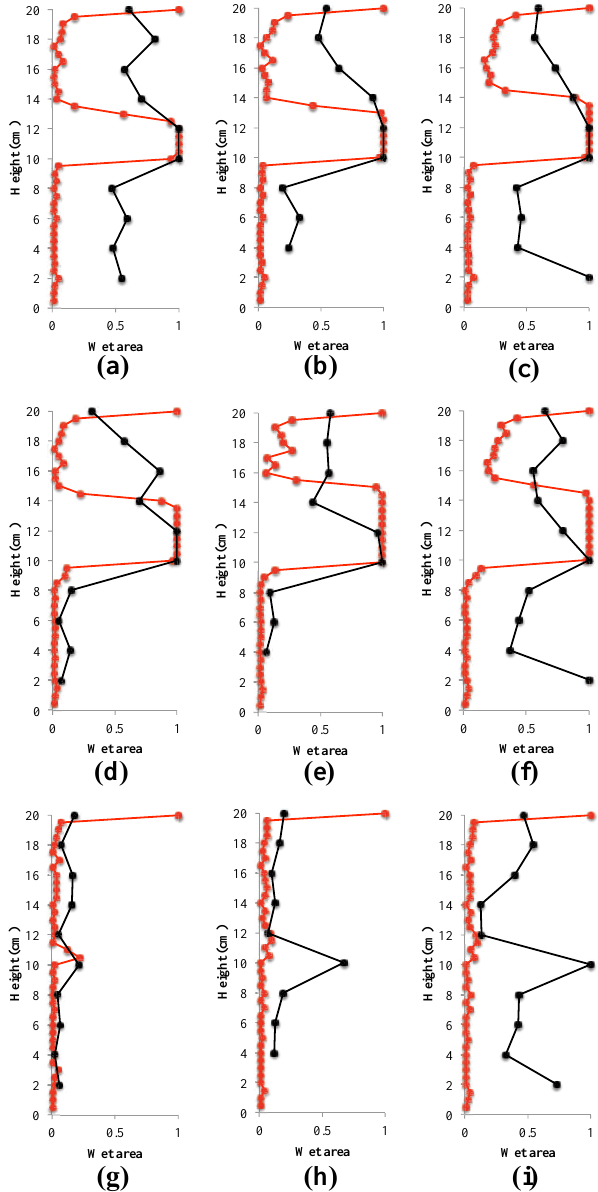
Figure 4. Profiles of wet area for experiments (red line) and simu- lations (black line): (a) FC1, (b) FC2, (c) FC3, (d) FM1, (e) FM2, (f) FM3, (g) MC1, (h) MC2, and (i) MC3.